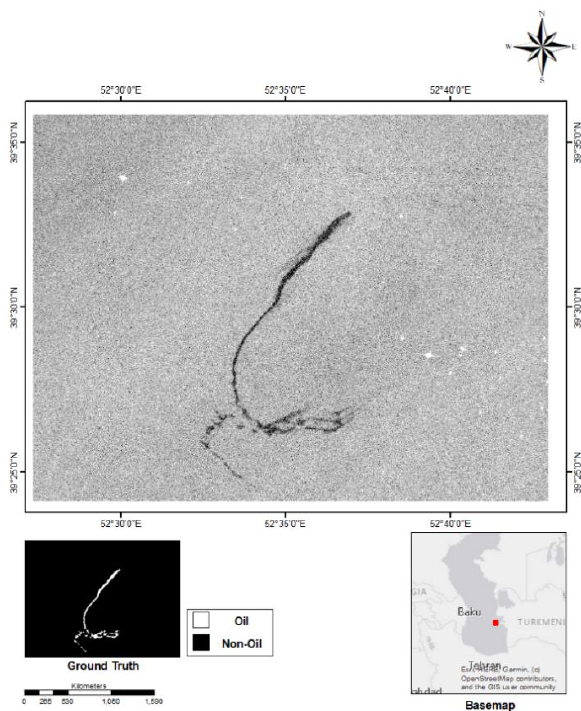
Figure 5 . Display of the SAR Image and its ground truth with the approximate location of the oil